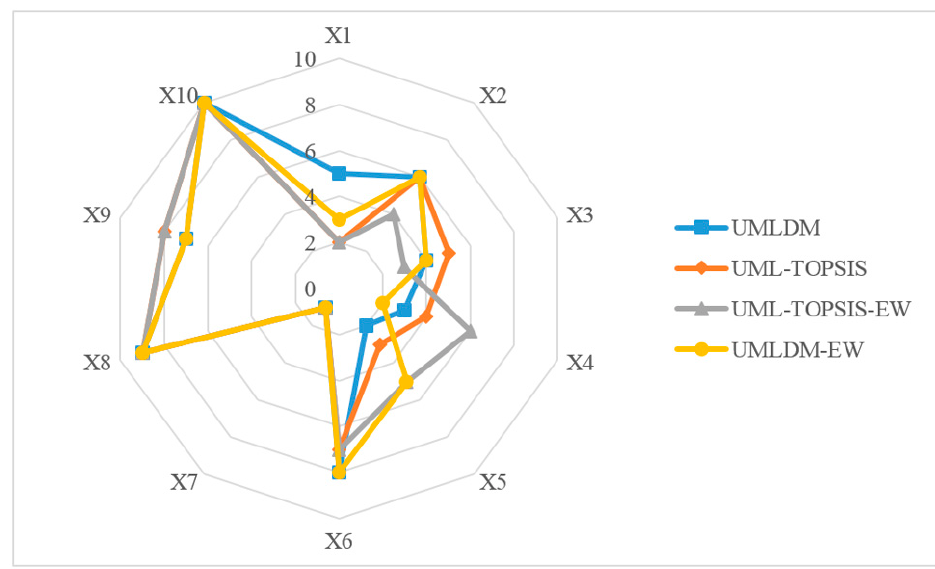
Figure 10. The group rankings of 10 mobile medical APPs determined by 4 FMAGDM based on group compromise ranking